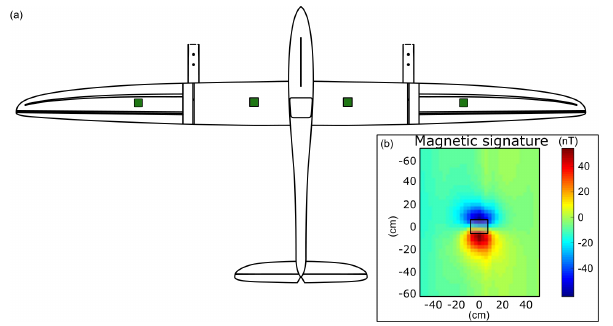
Figure 4. Locations of the replaced servomotors and the magnetic signature of the new BLDC servomotor: (a) the locations of the re- placed servomotors, indicated by green squares, and (b) the mag- netic signature of the new low-magnetic servomotor. The small black square in the middle indicates where the servomotor was lo- cated, and the servomotor was off during the measurement. The measurement was conducted on a planar 10cm above the servo- motor.